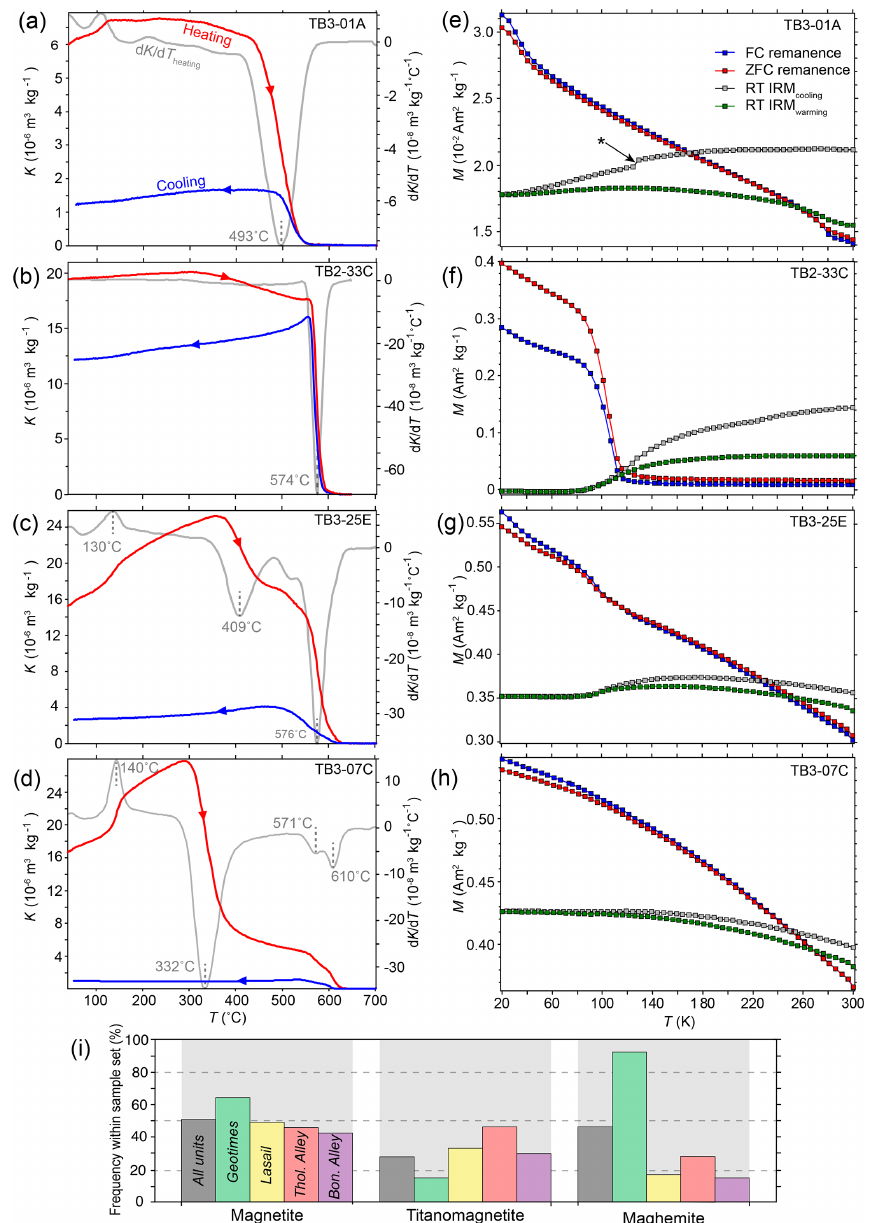
Figure 9. Magnetic mineralogy of the Semail volcanics. ( a – d ) High-temperature magnetic susceptibility ( K ) of four representative samples with the first derivative of the heating curve (temperatures marked at d K/ d T minima/maxima). (a) Titanomagnetite in relatively fresh Boninitic Alley (TB3-01A). (b) Magnetite in Tholeiitic Alley (TB2-33C). (c) A mixture of maghemite and magnetite in Felsic Alley (TB3- 25E). (d) Maghemite in Geotimes (TB3-07C). ( e – h ) Low-temperature FC and ZFC remanences and RT-IRM during cooling and warming of the same samples as in a – d . Asterisked “transition” in (e) possibly caused by unintentional movement of the sample. (i) Frequency of ferromagnetic mineral occurrences (excluding weakly magnetic hematite) deduced from high- and low- T experiments for the entire sample set ( n = 36) and within each unit ( n Geotimes = 14, n Lasail = 6, n Thol. Alley = 9, n Bon. Alley = 11). Where multiple magnetic minerals are detected in a single sample, all the minerals contribute to the unit